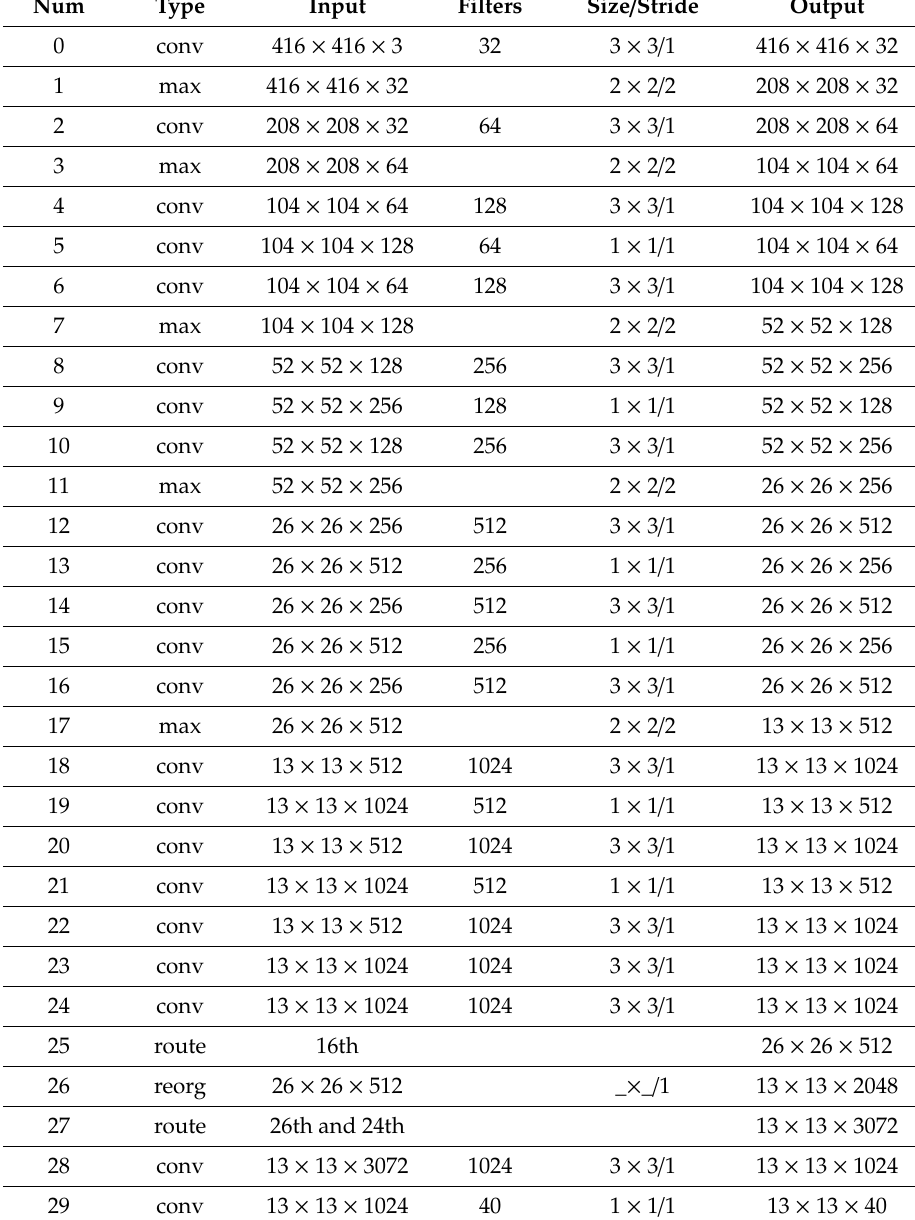
Table 2. The network structures of